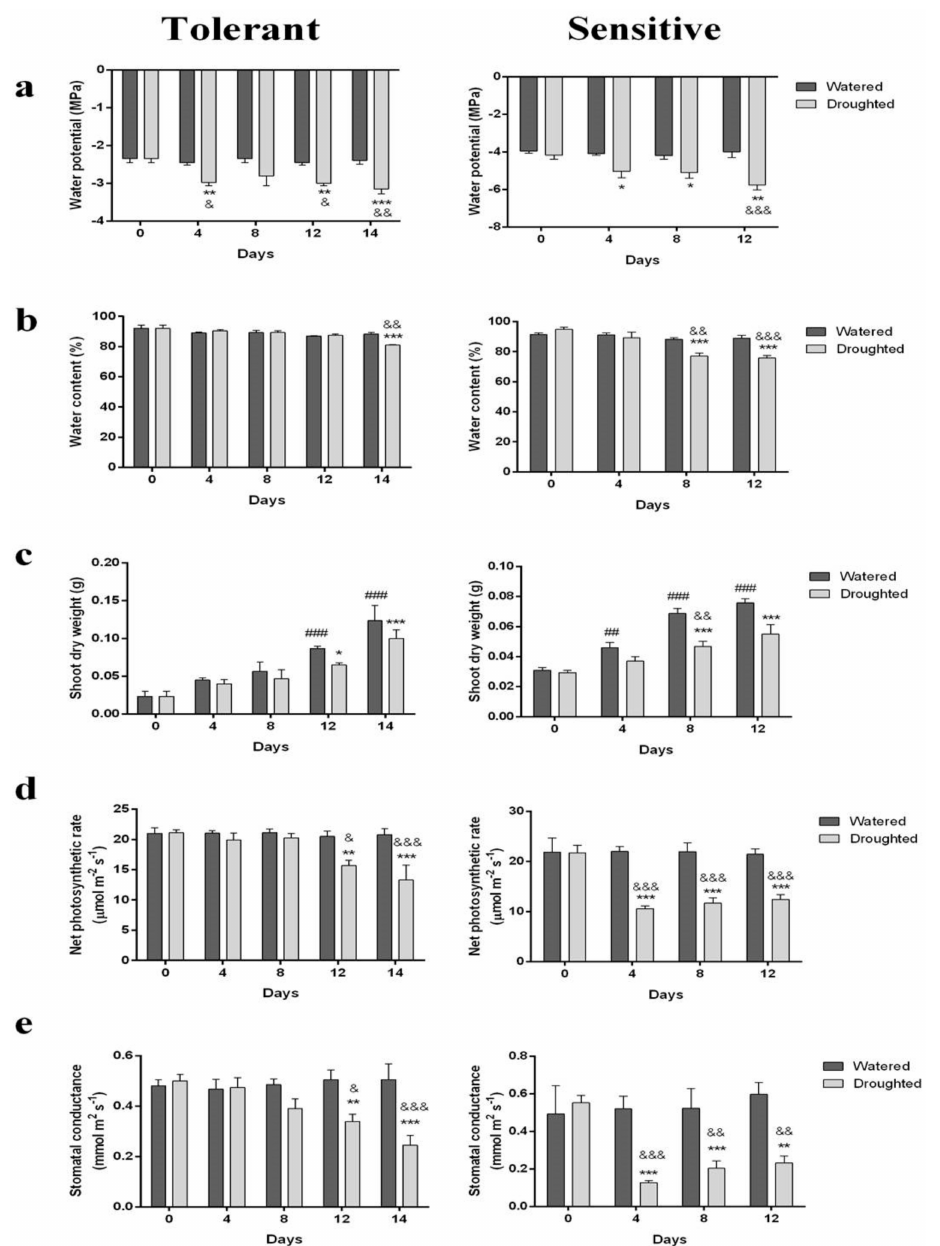
Figure 1. The e ff ects of drought stress on the physiological parameters in the sensitive (right) and tolerant (left) thyme plants: ( a ) the leaf water potential (MPa); ( b ) water content (%); ( c ) shoot dry weight (g); ( d ) net photosynthetic rate ( µ mol m − 2 s − 1 ); ( e ) stomatal conductance (mmol m 2 s − 1 ). * p < 0.05 vs. day 0 of Droughted group; ** p < 0.01 vs. day 0 of Droughted group, *** p < 0.001 vs. day 0 of Droughted group, ## p < 0.01 vs. day 0 of Watered group; ### p < 0.001 vs. day 0 of Watered group; & p < 0.05 Droughted vs. Watered group; && p < 0.01 Droughted vs. Watered group; &&& p < 0.001 Droughted vs. Watered group. Data are expressed as the mean ± S.E.M. Two-way ANOVA followed by the Sidak’s multiple comparisons test was